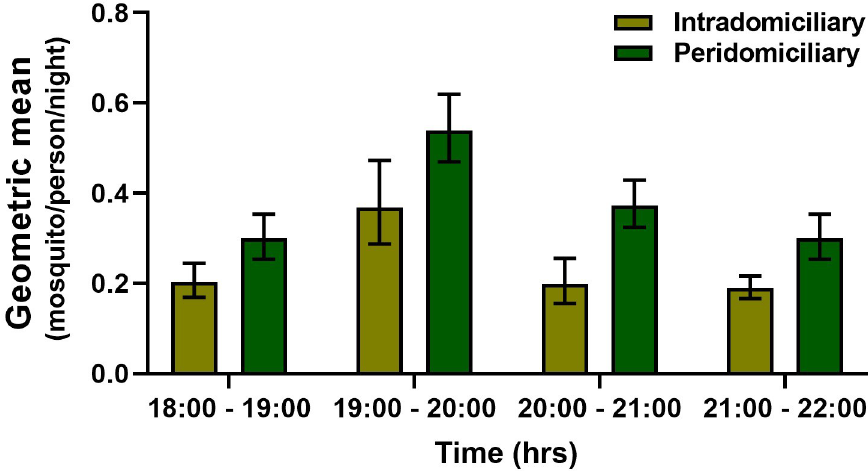
Fig 2. Biting activity per hour of Anopheles (Nys . ) darlingi in five communities of the Darien region, between March and November 2016 (geometric mean ± 95% confidence interval).